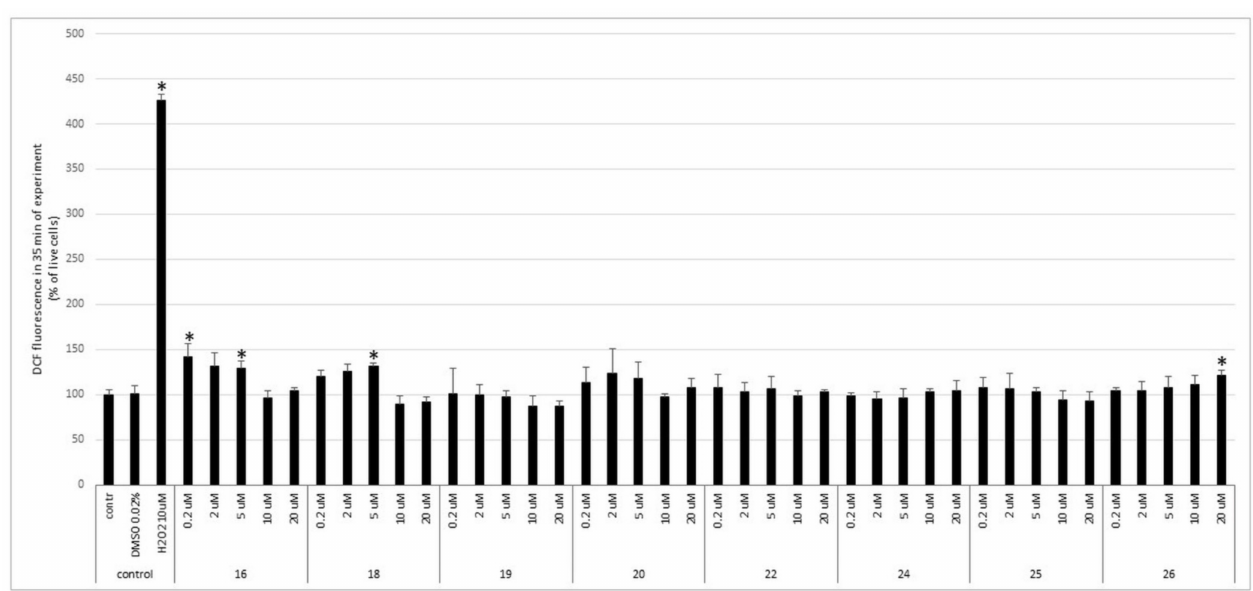
Figure 4. The effect of different concentrations (0.2, 2, 5, 10, and 20 µ M) of cationic 16 , 18 , 20 , 22 , 24 , and 26 bola dendrimers and their neutral precursors 19 and 25 on ROS production in CGC during 30 min incubation in Locke 5 medium. Positive control-fluorescence after addition of 10 µ M H 2 O 2 . Results shows differences in DCF fluorescence at the end of experiments. Results are presented as mean ( ± SD) from four repetitions compared to vehicle (0.2% DMSO). * result statistically significant vs. DMSO, p < 0.05, one-way